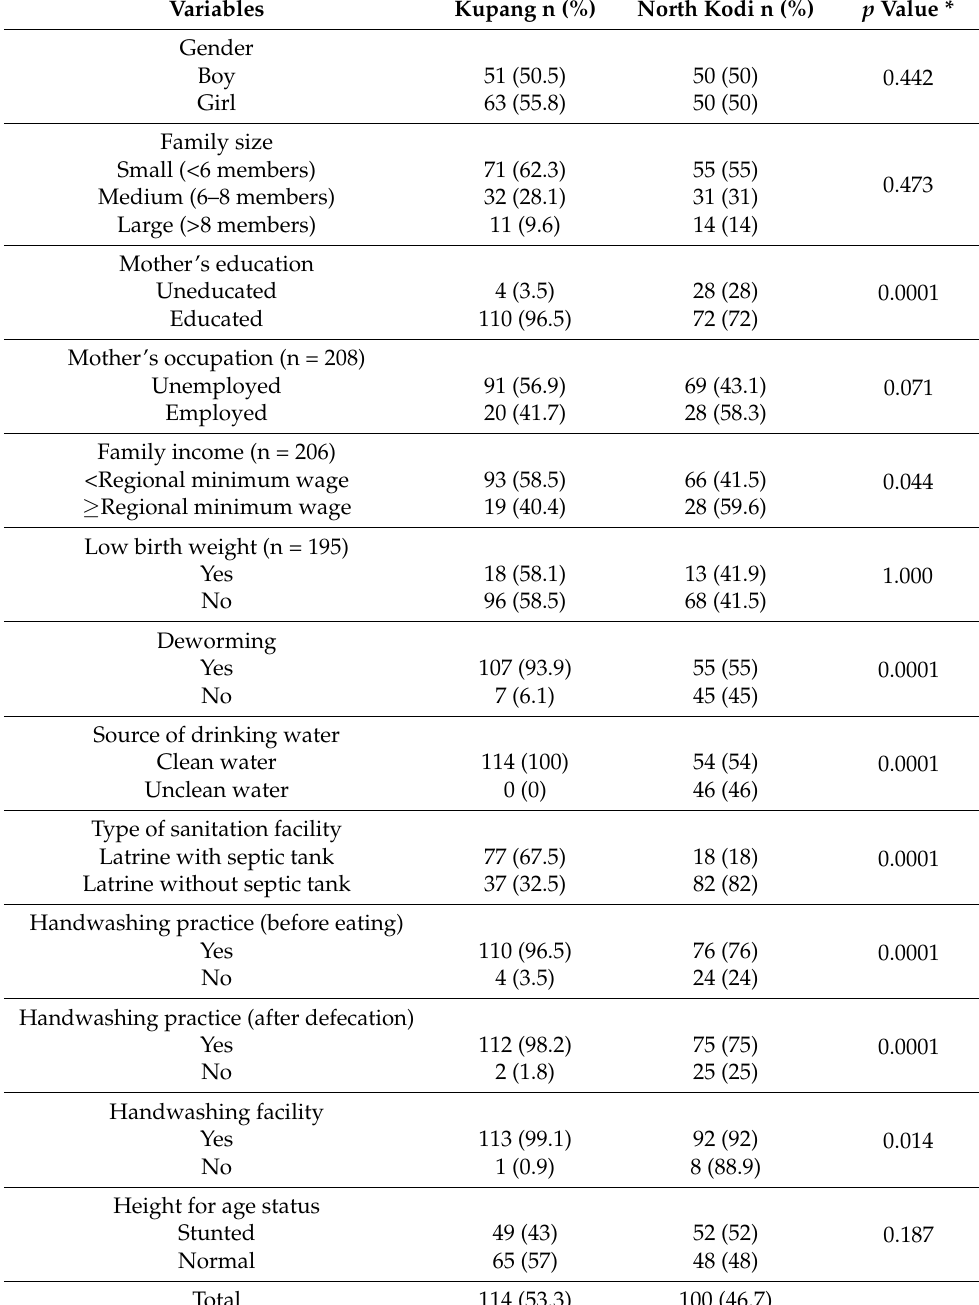
Table 2. Sociodemographic and hygiene practice characteristics of children aged 36–45 months from Kupang and North Kodi, East Nusa Tenggara Timur, Indonesia.